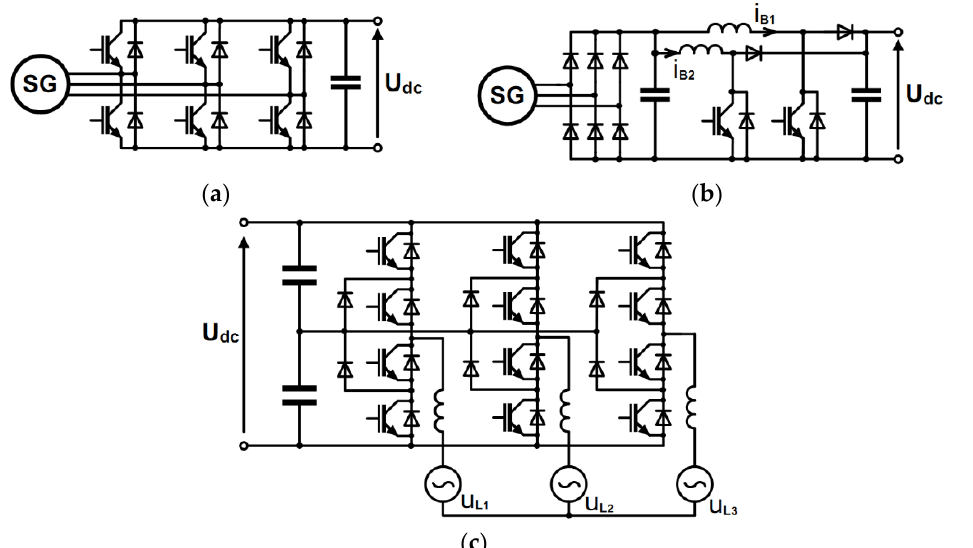
Figure 1. Structure of converters: ( a ) generator with topology T1; ( b ) generator with topology T2 and ( c ) grid.